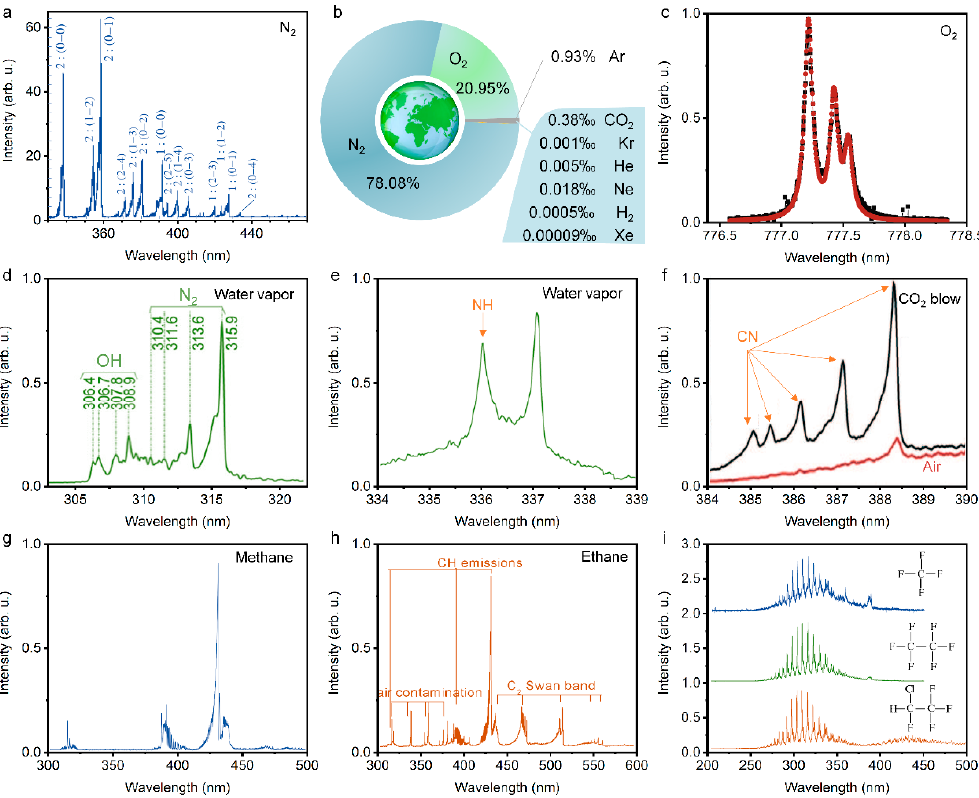
Figure 18. ( a – f ) Chemical composition ( b ) and corresponding FIPS spectra ( a , c – f ) in atmosphere [136,184,190,256,268]. ( g – i ) FIPS spectra of several representative organic pollutants in atmosphere [191,258,269].